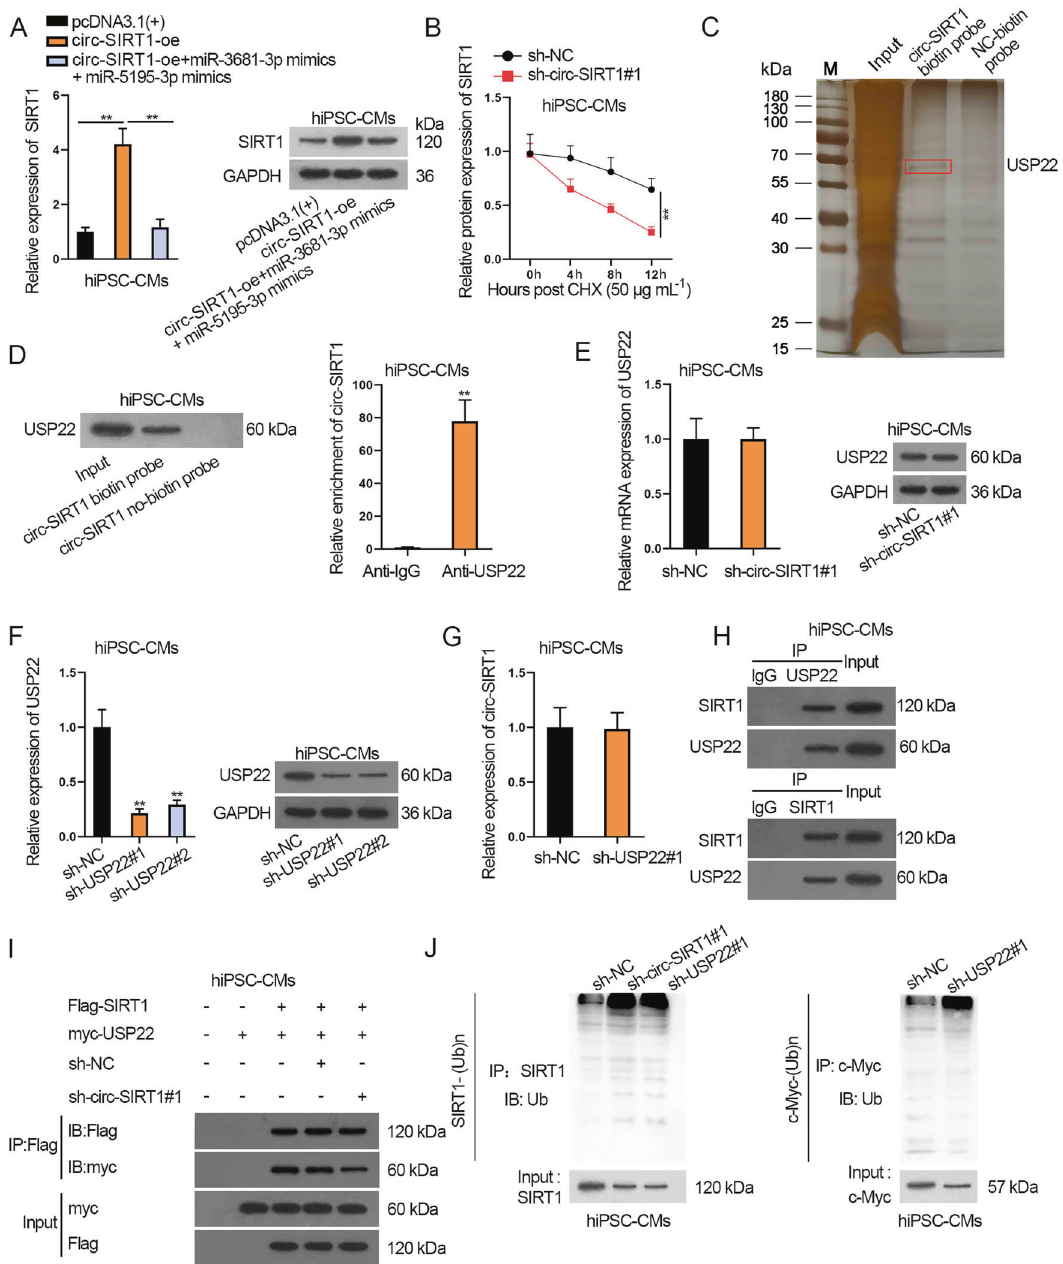
Fig. 5 Circ-SIRT1 recruits USP22 to regulate the deubiquitination and stabilization of SIRT1 in hiPSC-CMs. A SIRT1 mRNA and protein expression in hiPSC-CMs transfected with pcDNA3.1( + ), circ-SIRT1-oe, or circ-SIRT1-oe + miR-3681-3p mimics + miR-5195-3p mimics were analyzed via RT-qPCR and western blot analyses. N = 3. B SIRT1 protein stability was analyzed by western blot at 0, 4, 8, and 12 h after CHX treatment in hiPSC-CMs. N = 3. C Silver staining of differential proteins in RNA pull-down products for circ-SIRT1 biotin probe compared with NC-biotin probe. The differential bands were sent to mass spectrometry and USP22 was shown to be signi fi cantly enriched in circ-SIRT1 biotin probe group in hiPSC-CMs. N = 3. D Western blot band of USP22 in RNA pull-down products for circ-SIRT1 biotin probe and circ-SIRT1 no- biotin probe. RT-qPCR results of circ-SIRT1 enrichment in RIP precipitates for anti-IgG and anti-USP22. N = 3. E RT-qPCR and western blot analyzed the effect of silenced circ-SIRT1 on USP22 expression. N = 3. F RT-qPCR and western blot analyses of the ef fi ciency of USP22 knockdown by sh-USP22#1/2 in hiPSC-CMs. N = 3. G RT-qPCR analysis of the effect of silenced USP22 on circ-SIRT1 expression. N = 3. H Western blot band of SIRT1 and USP22 in the CoIP products for anti-IgG and anti-USP22. N = 3. I The hiPSC-CMs were transfected